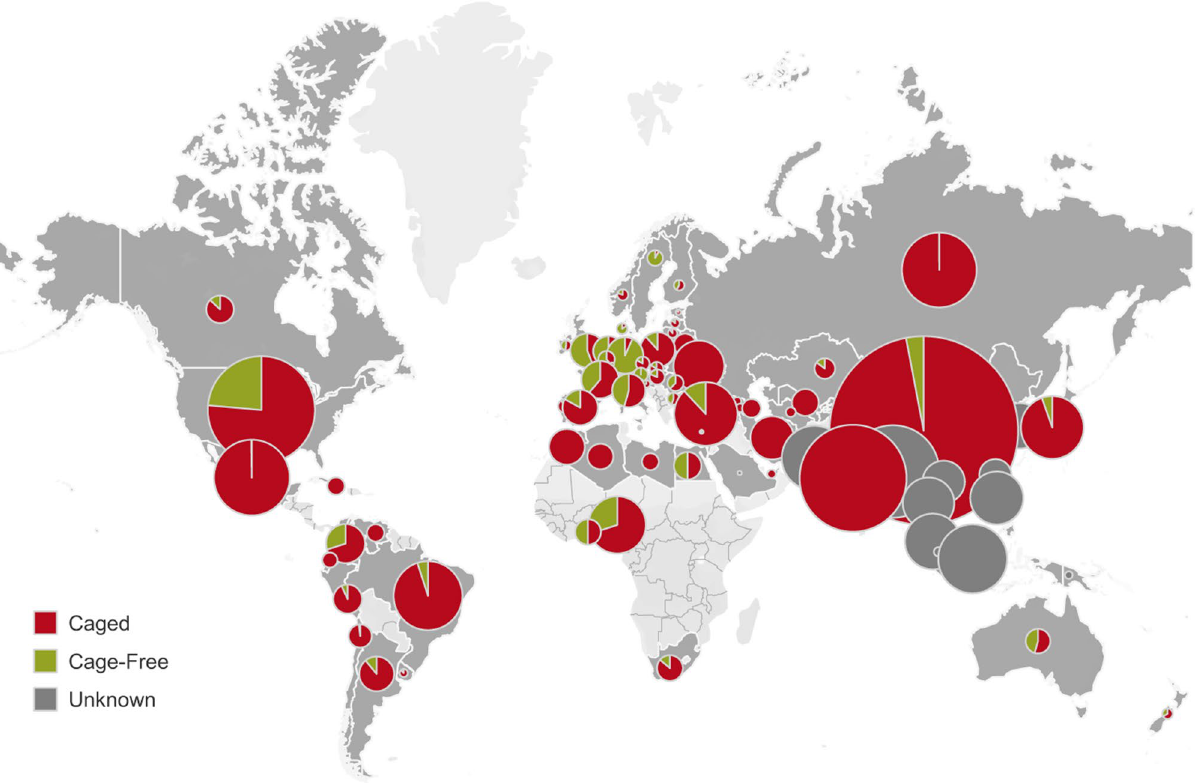
Figure 1. Global distribution of laying hens by housing system. Distribution of laying hens in caged (red: conventional; furnished) and cage-free (green: barns, aviaries, free-range) systems in 78 countries (dark grey) for which hen inventories are available. The size of circles is proportional to the hen population in the country. Dark grey circles: countries for which the hen population is known, but the proportion of hens in each housing system is unknown. An interactive version of this figure is available at http://hen-welfa re.org/map, with further information available (by clicking on the pie charts) on data sources, proportion of hens in each system and layer populations. The map and graphic components were developed with the software Tableau Public, version 2020.3 (http://publi c.table